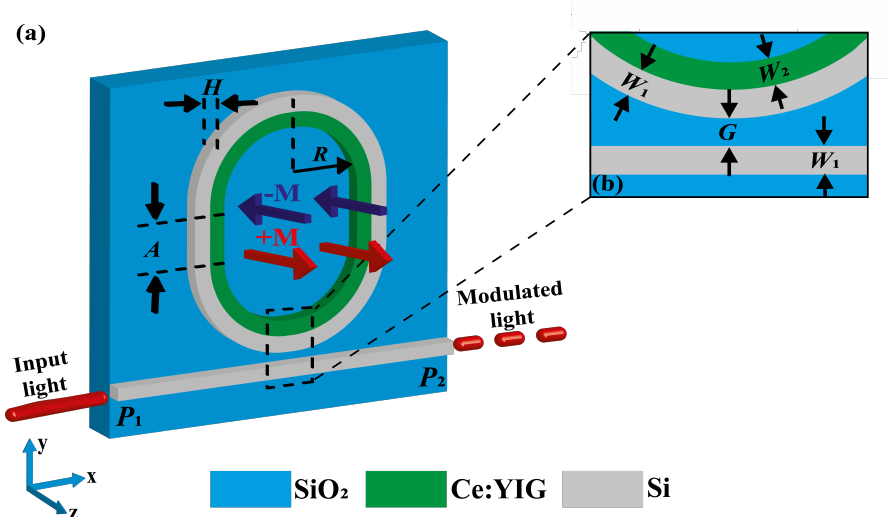
Figure 1. ( a ) Schematic 3D of the MO-MRR and ( b ) a zoom-in of the highlighted region in ( a